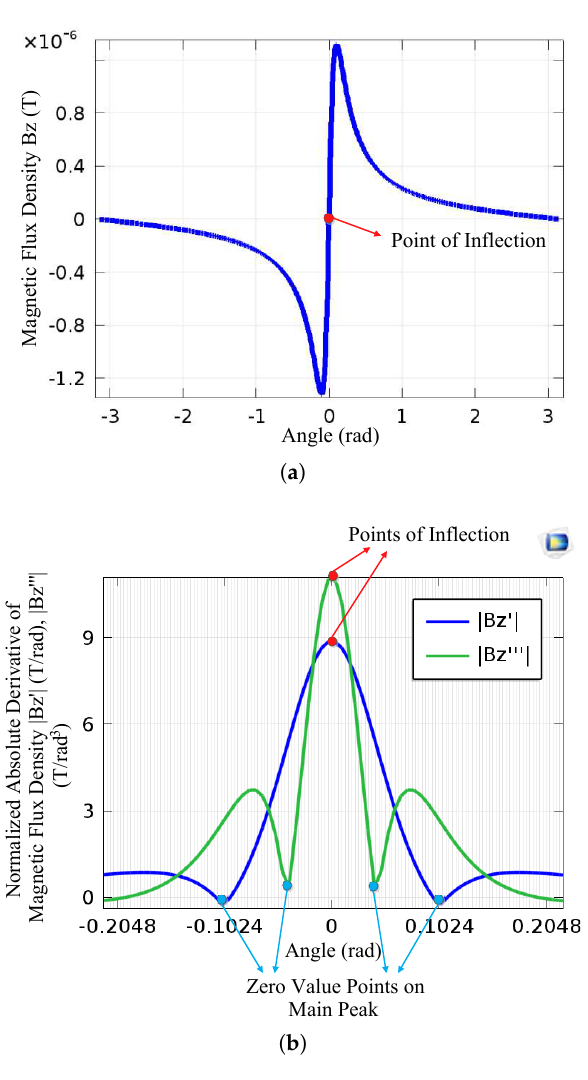
Figure A1. ( a ) The magnetic flux density function (cid:126) B z in (5) has an inflection point at 0 rad, marked as red. ( b ) Absolute 1st and 3rd order derivative of the function (cid:126) B z . According to the oscillating behavior of the higher derivatives and absolute values, point of inflection marked as red has the maximum value on the main peak. The points in blue indicate the zero value points on the main peak while the angular width between the zero value points on the main peak is the main peak